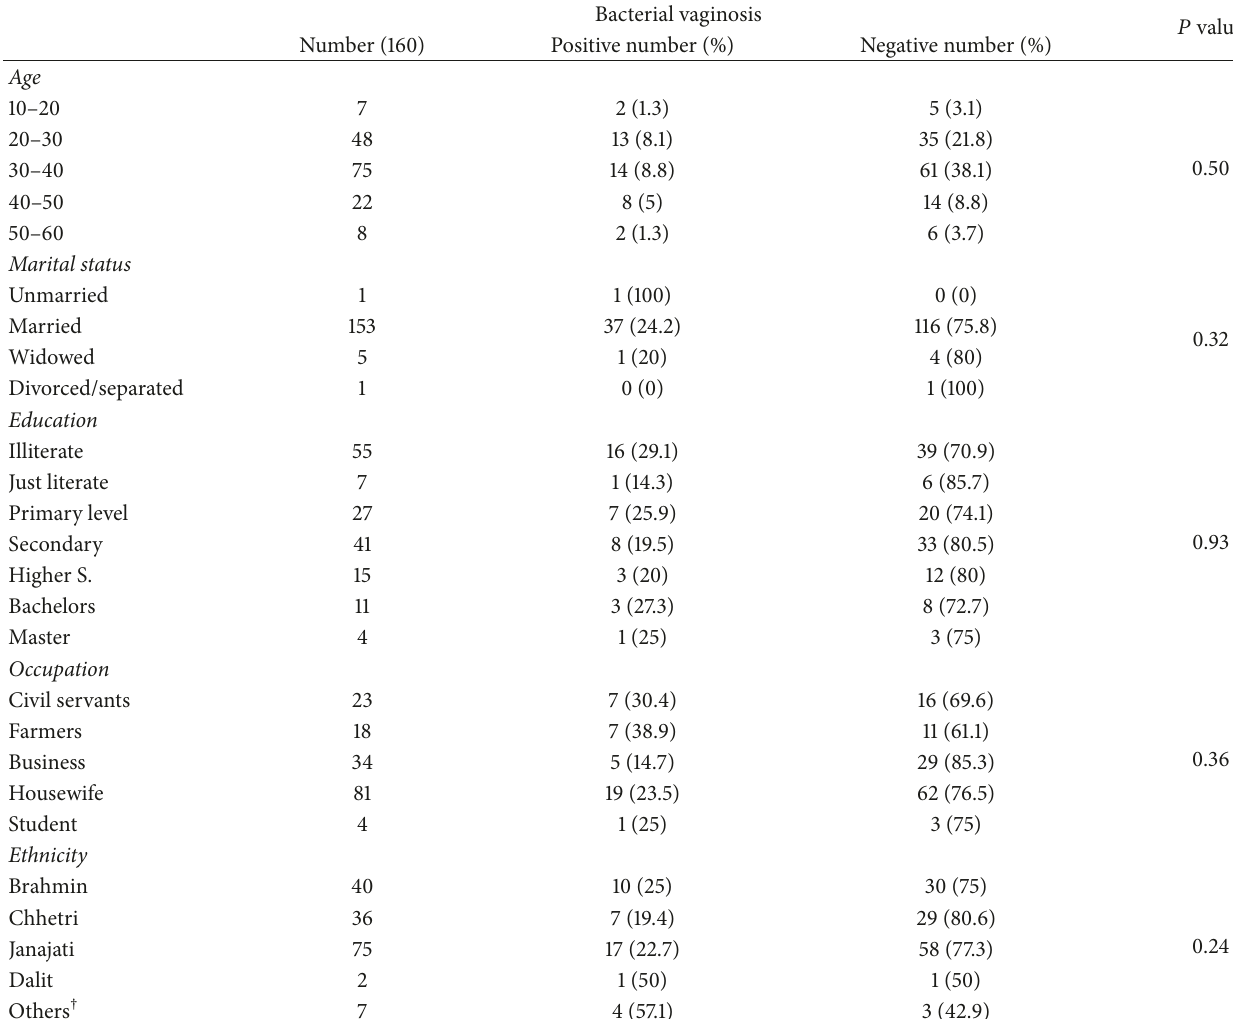
Table 2: Sociodemographic characteristics of sample